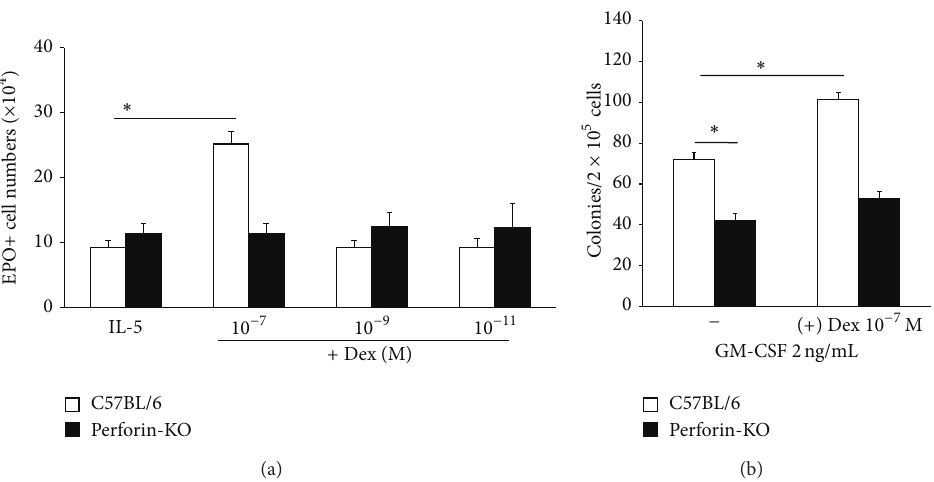
Figure 3: Effectiveness of dexamethasone on in vitro eosinopoiesis in B6 and Pfp bone-marrow cultures. (a) IL-5-induced eosinopoiesis in liquid culture. Data are Mean + SEM of the number of EPO+ cells recovered from 7-day cultures established from B6 ((a), white bars) or Pfp ((a), black bars) in the presence of IL-5 (1ng/mL). Dex, dexamethasone. Data were from 3 separate experiments, carried out in 3 different days, each providing data from 3 B6 and 3 Pfp mice ( 𝑛 = 9 for both strains). (b) GM-CSF-stimulated colony formation in semisolid culture. Data are Mean + SEM of colony counts in 7-day semisolid cultures from B6 (white bars) and Pfp (black bars) bone-marrow established in the presence of GM-CSF (2ng/mL), alone or in association with Dex ( 10 −7 M). For cultures without (left) and with (right) Dex, data are, respectively, from B6, 𝑛 = 14 and 𝑛 = 7 ; Pfp, 𝑛 = 12 and 𝑛 = 6 . ∗ Significant difference between the indicated